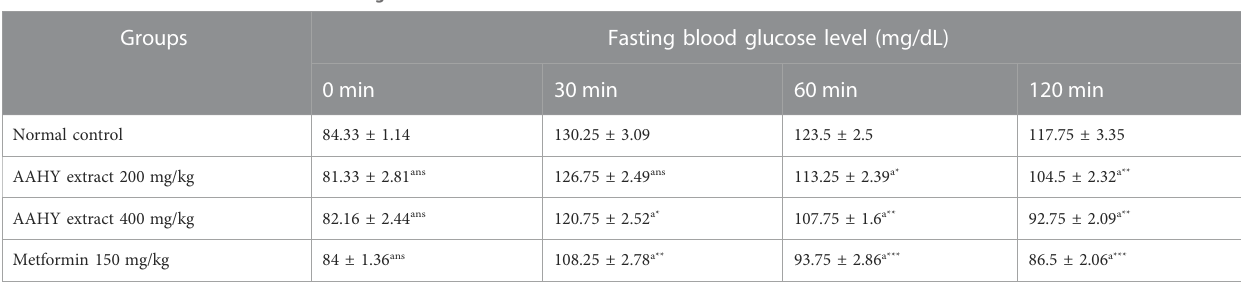
TABLE 2 Effect of the AAHY extract in the oral glucose tolerance test.